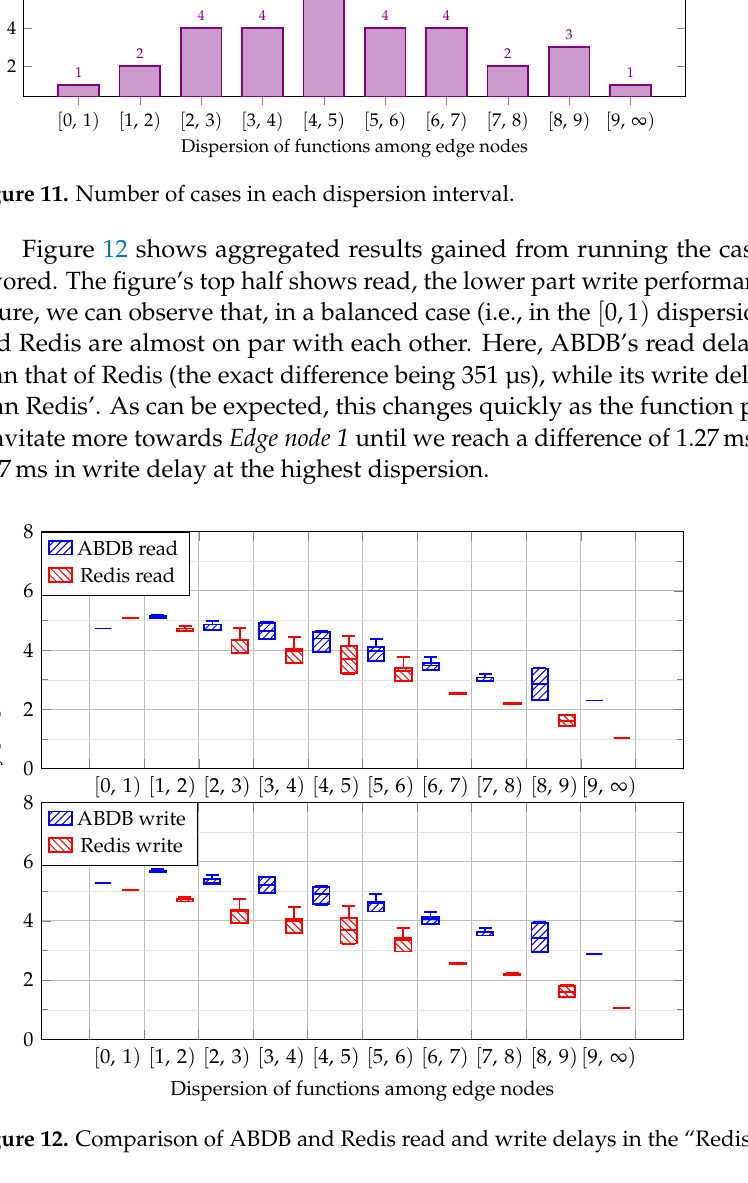
Figure 12. Comparison of ABDB and Redis read and write delays in the “Redis-favored” scenario. The second setup disfavors Redis by mostly avoiding Edge node 1 for function